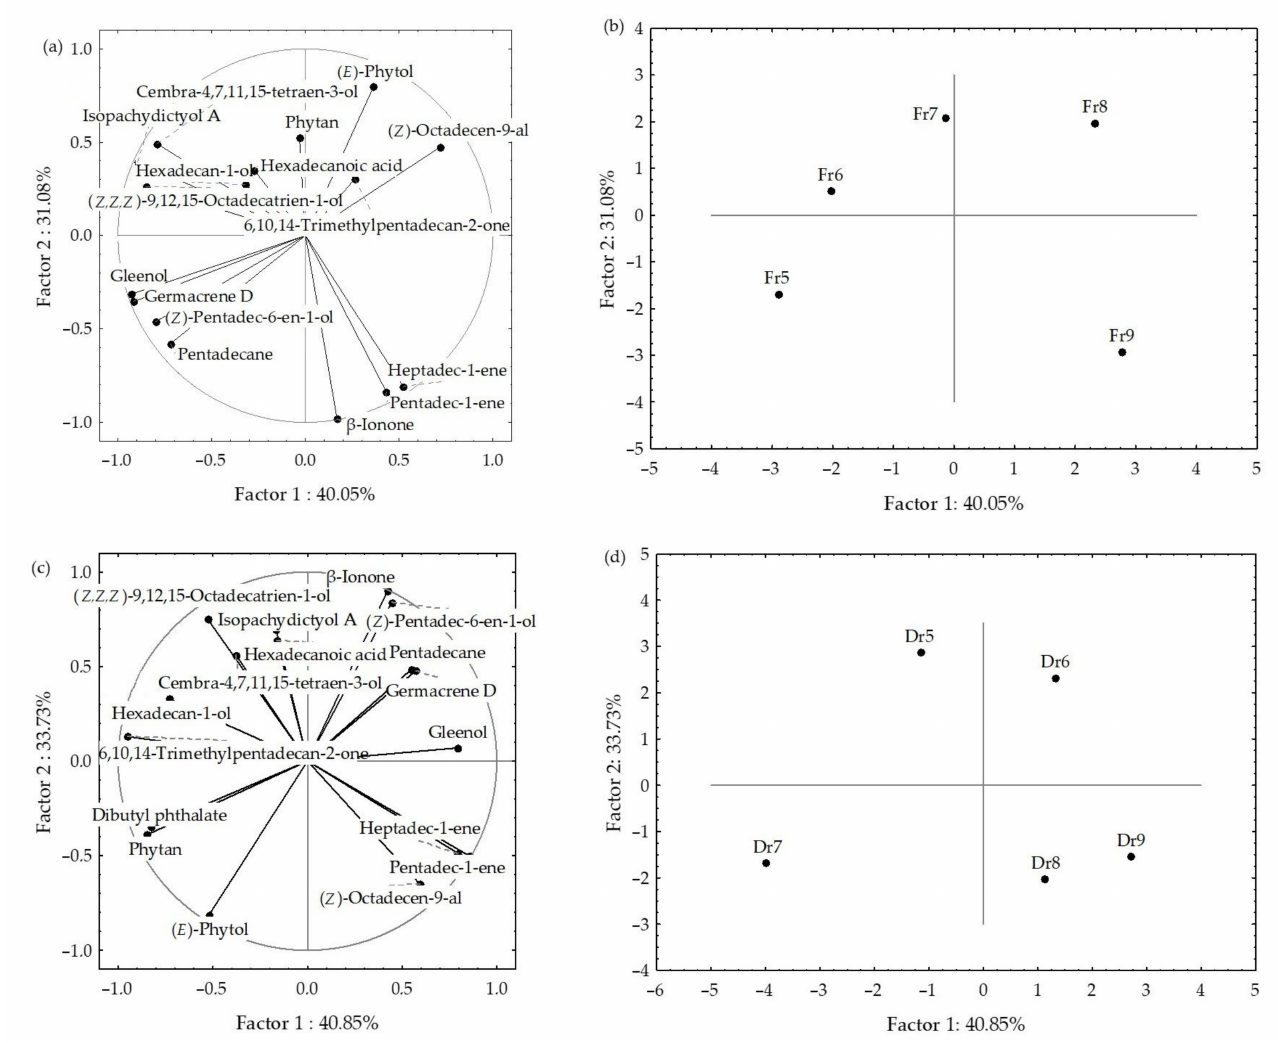
Figure 9. Correlation loadings ( a , c ) and score plot ( b , d ) of the dominant VOCs of fresh (Fr, a , b ) and air-dried (Dr, c , d ) H. scoparia samples obtained by